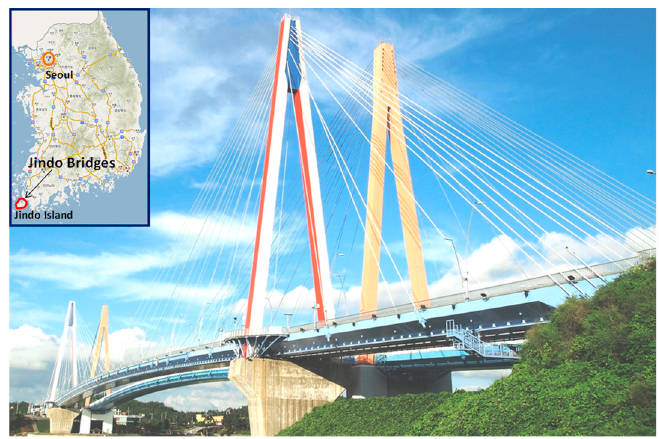
Figure 1. Jindo Bridges. The bridge on the left is the subject of this study.